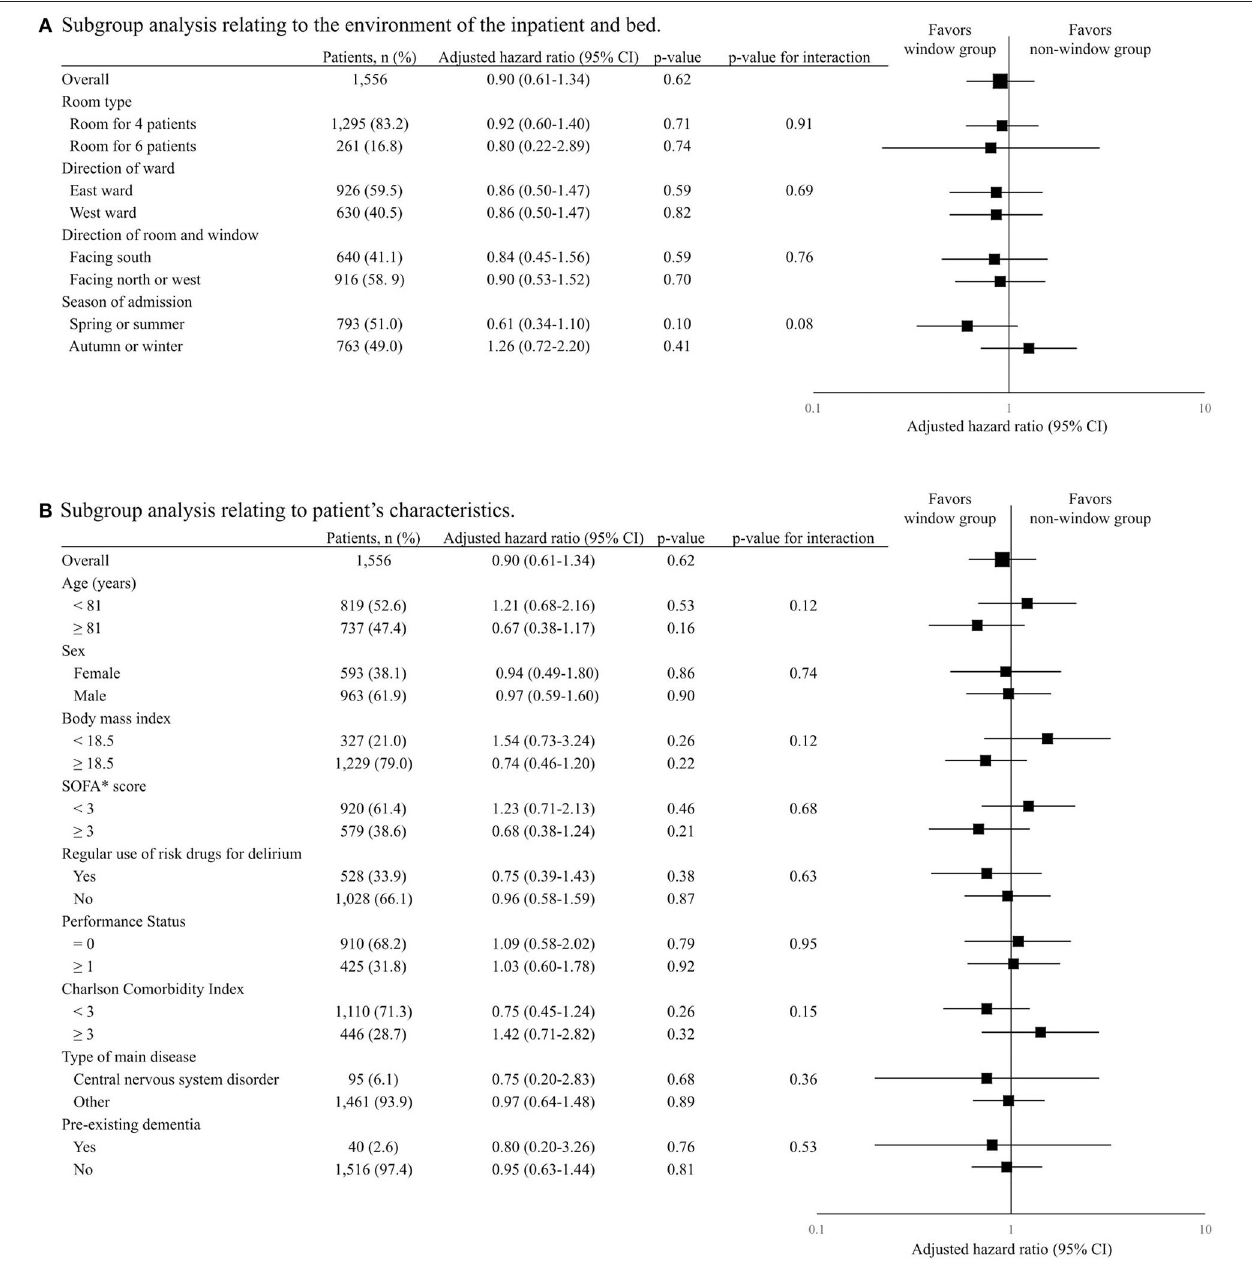
FIGURE 4 | Subgroup analysis on the association of window group with primary outcome. The table and forest plot show the adjusted hazard ratio of the window group for delirium with event within 14 days after admission for each subgroup. The results of subgroup analyses in terms of inpatient environment and bed are shown in (A) and those regarding patient characteristics are shown in (B) . In the forest plot, black squares show the adjusted hazard ratio and horizontal lines show 95% CIs. Hazard ratio was modified using the Cox regression model adjusted for age, sex, low body weight, sequential organ failure assessment score, regular use of risk drugs for delirium before admission, performance status, Charlson comorbidity index, admission for central nervous system disorders, and pre-existing